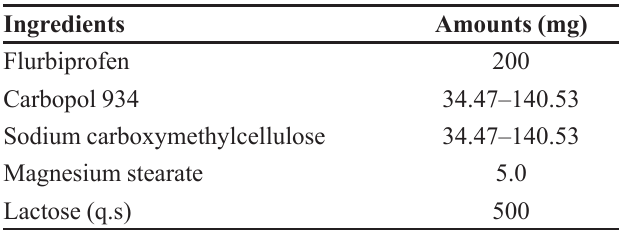
TABLE I - Composition of different ingredients used per tablet Ingredients